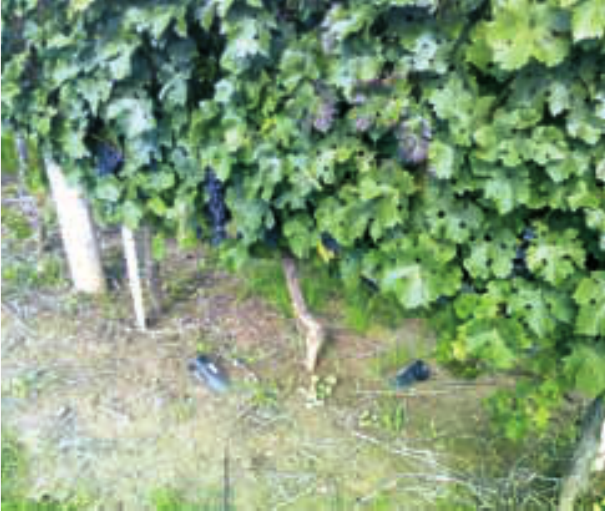
Figure 1: Installation of observation tubes in the vineyard in